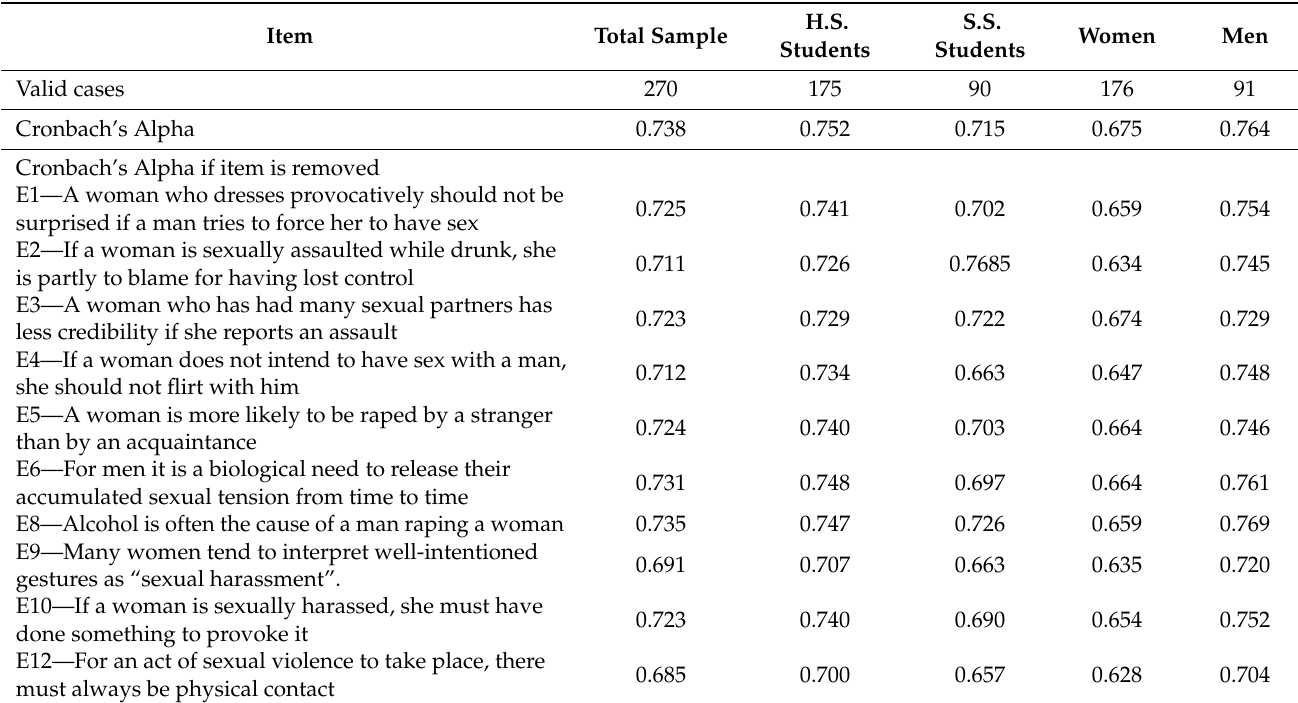
Table 5. Cronbach’s Alpha study 1